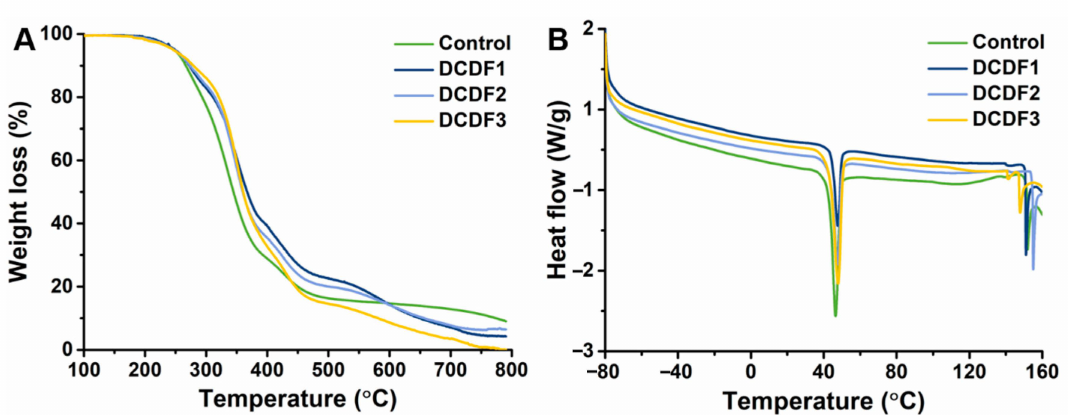
Figure 4. Thermal properties of the control group and DCDFs by ( A ) thermogravimetric analysis and ( B ) differential scanning calorimetry. Control group: thin films without